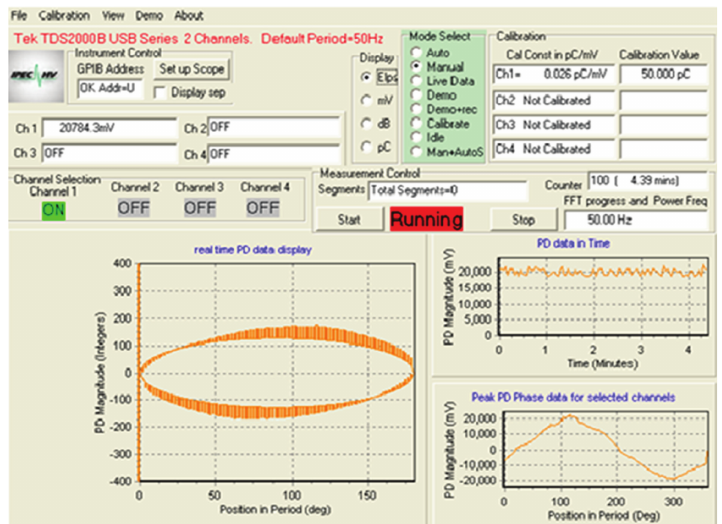
Figure 15: Typical sample of laboratory model testing of electrode bounded cavity with air corona PD acquired from the PD measurement and acquisition system.